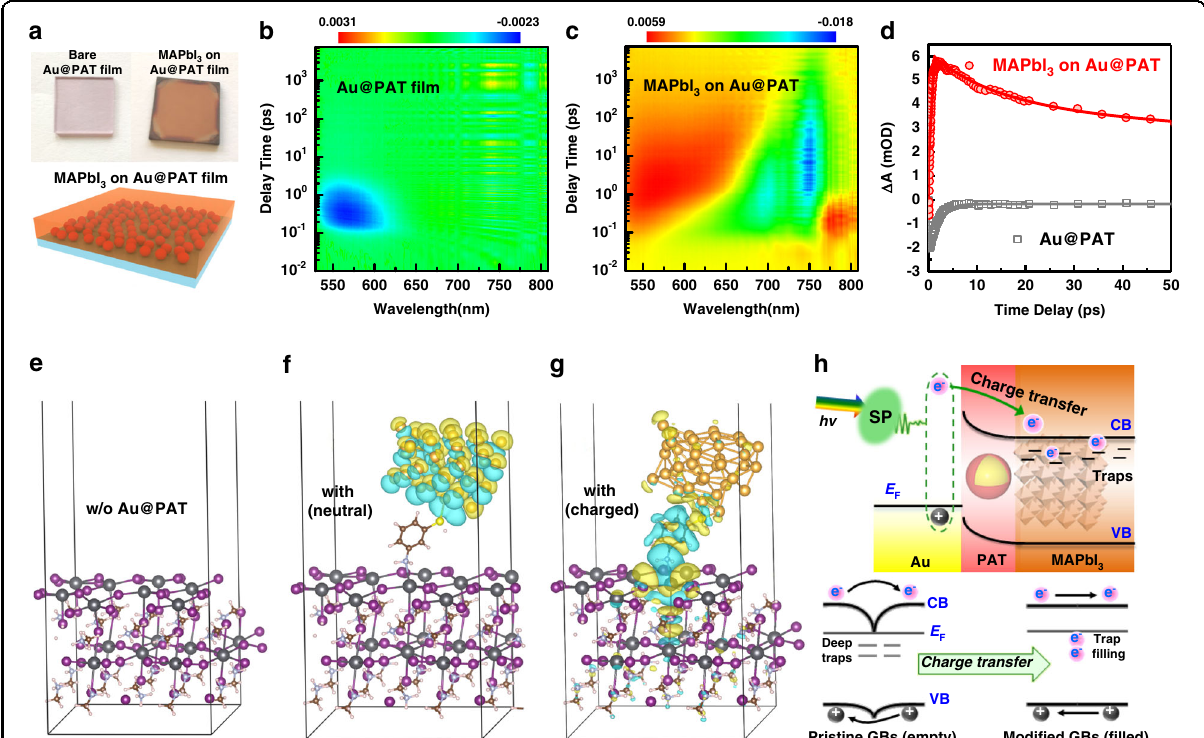
Fig. 5 Proposed mechanism for photo-induced plasmonic cleaning. a The optical images of the Au@PAT fi lm assembled from colloidal solution and the Au@PAT/MAPbI 3 bilayer fi lm. The schematic below shows the bilayer structure of perovskite deposited on Au@PAT fi lm assembled on quartz glass. b , c Pseudo-colour TA spectra of Au@PAT fi lms on bare glass substrates without and with MAPbI 3 fi lm deposition under photoexcitation wavelength of 532 nm. d Charge dynamics probed at the 580 nm (bleach peak of Au@PAT fi lm) of bare Au@PAT and Au@PAT/MAPbI 3 bilayer samples. e – g Theoretical calculations of intermolecular interactions using density functional theory (DFT). Charge-density difference distribution of the (001) slab of untreated MAPbI 3 surface with under-coordinated Pb defects ( e ), 3-aminothiophenol-capped Au 38 cluster on MAPbI 3 surface without additional charge ( f ), and charged by one additional electron ( g ). Charge accumulation and depletion are shown in yellow and blue, respectively. Au, Pb, I, C, N, S, and H are denoted in golden, grey, purple, brown, cyan, yellow, and pink spheres, respectively. h Schematic depicting the PHET mechanism at Au@PAT/MAPbI 3 interfaces for trap fi lling. The carrier-dynamic diagrams at the GBs before and after the hot-electron injection from Au@PAT is